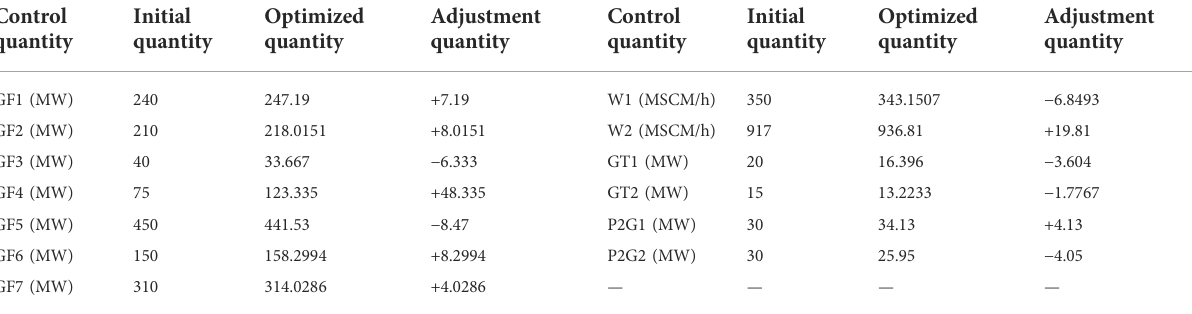
TABLE 2 Adjustment of control quantity using optimal load shedding strategy in Reference (Yu et al.,